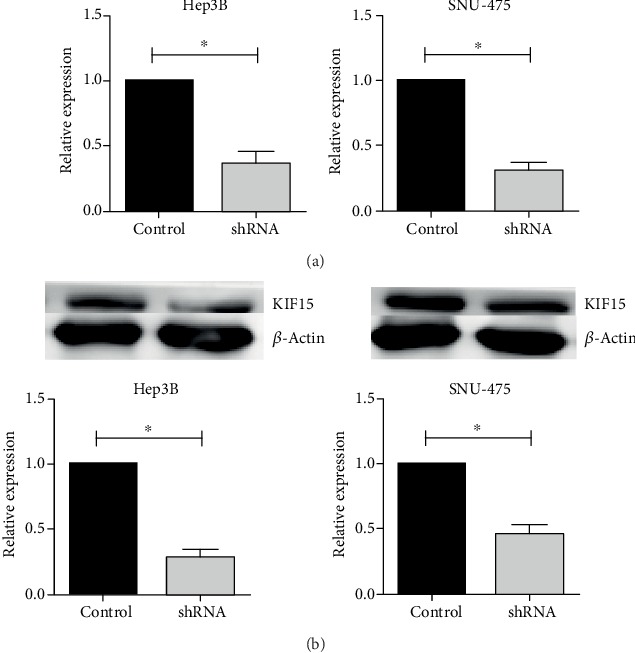
KIF15 expression was effectively inhibited in both Hep3B and SNU-475 human HCC cells caused by its shRNA plasmids. (a) Quantitative PCR assays revealed the dramatically reduced expression level of KIF15 caused by its shRNA in Hep3B and SNU-475 cells, respectively. (b) Immunoblot assays confirmed the efficiently silencing of KIF15 caused by the transfection of its shRNA plasmids in Hep3B and SNU-475 cells. Results are presented as mean ± SD, ∗P < 0.05.